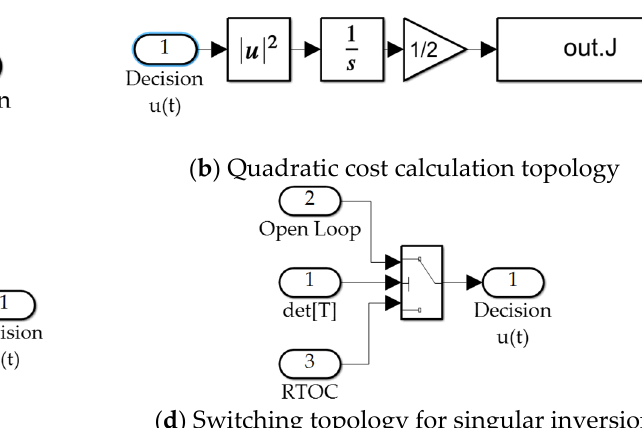
Figure 5. SIMULINK subsystems; ( a ) real-time optimal decision switching topology; ( b ) real-time optimal calculation of Equation (39) using backslash\inverse ; ( c ) real-time optimal calculation of Equation (39) using pinv inverse ; ( d ) real-time optimal calculation of Equation (39) using LU inverse .